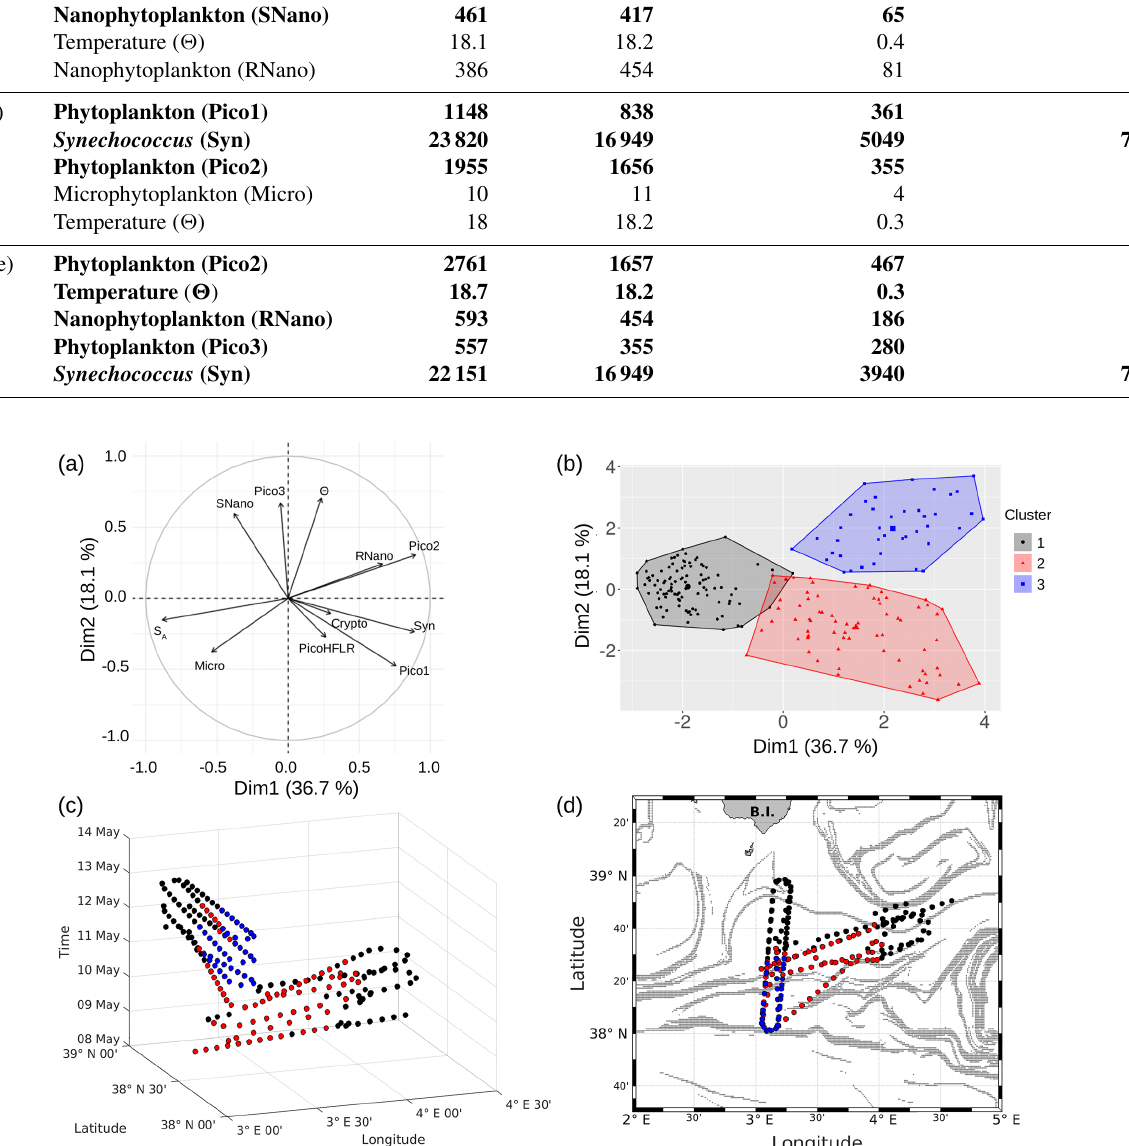
Figure 9. (a) Principal component analysis in the first factorial plane. (b) Representation in two dimensions of the three clusters obtained with the K -medoid algorithm. (c) Spatiotemporal representation of the three clusters obtained with the K -medoid algorithm. (d) Geographical representation of these clusters, superimposed upon the FSLE field, 11 May